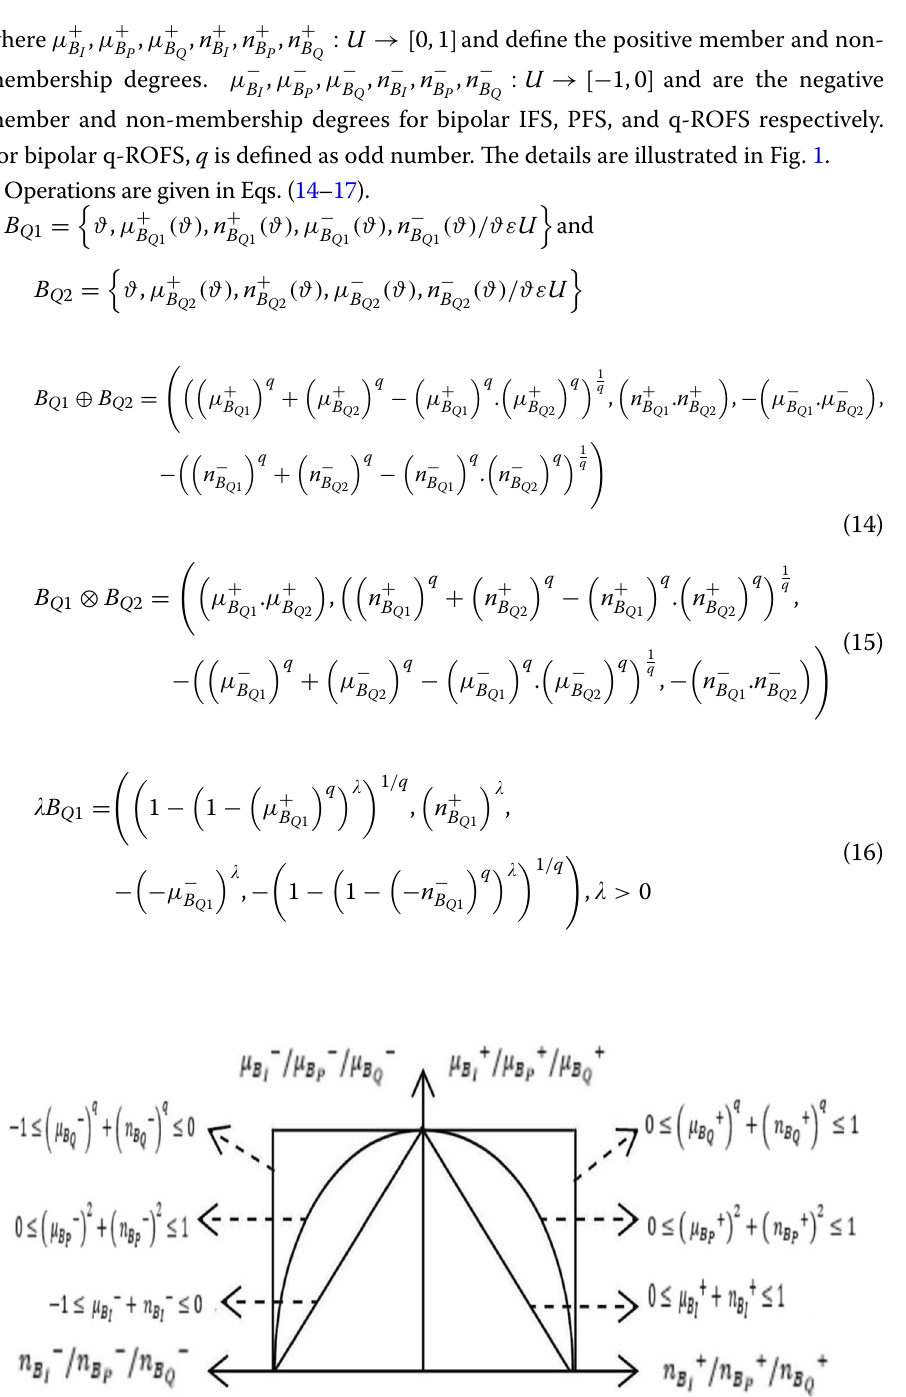
Fig. 1 Degrees of bipolar IFS, PFS, and